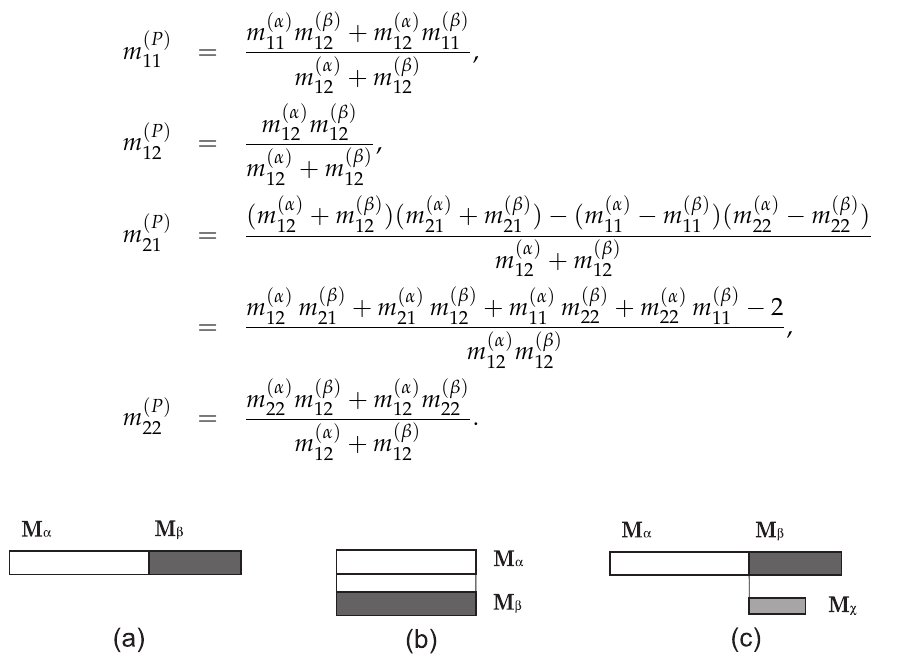
Figure 2. Different arrangements of single units. ( a ) Two units in series. ( b ) Two units in parallel. ( c ) Three units: α and β are in series and χ is inserted in parallel at the interface between the others